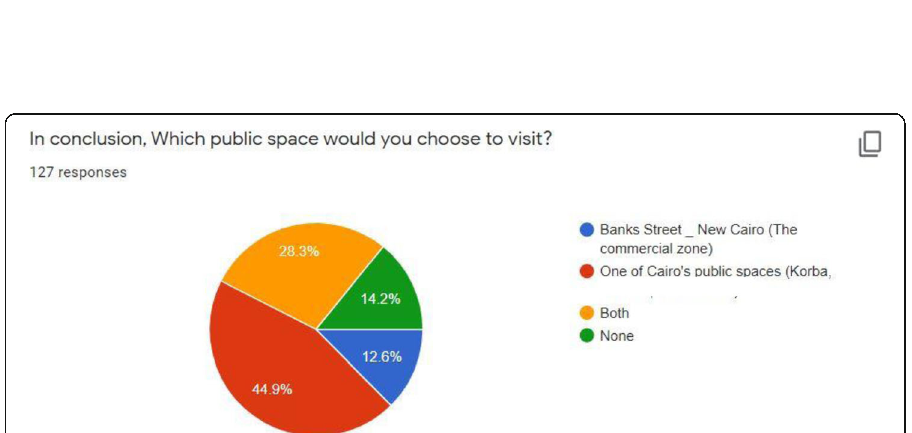
Fig. 26 Preferable public space chosen by users